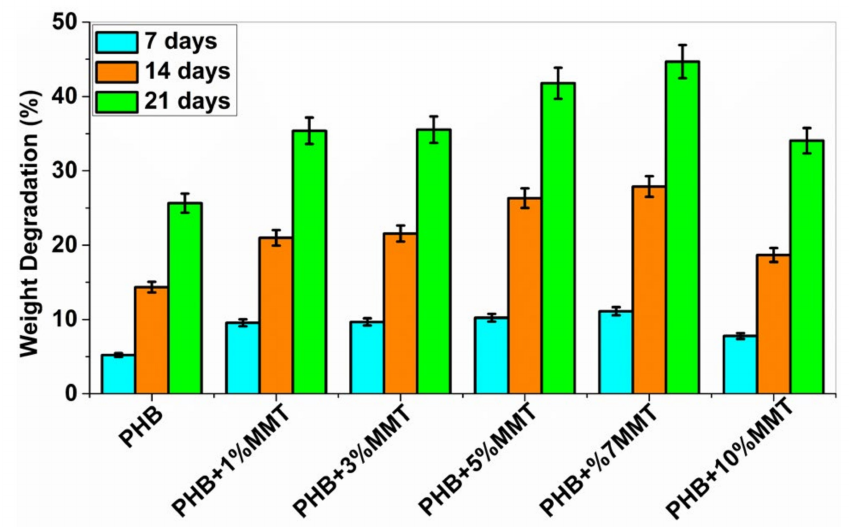
Figure 6. Graph showing % weight degradation of the different films by bacteria.